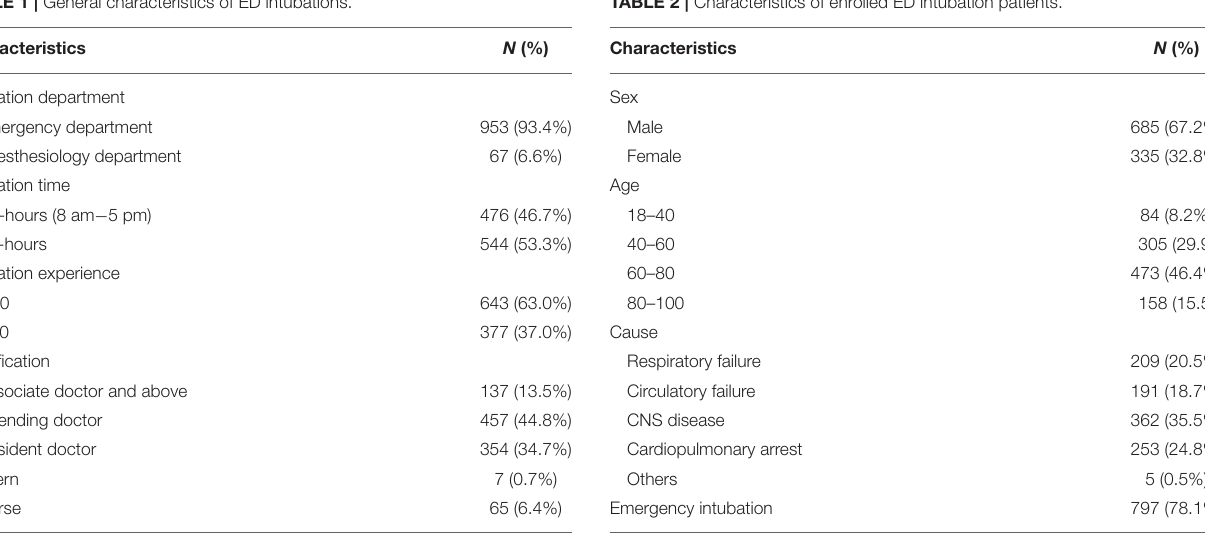
TABLE 1 | General characteristics of ED intubations. TABLE 2 | Characteristics of enrolled ED intubation